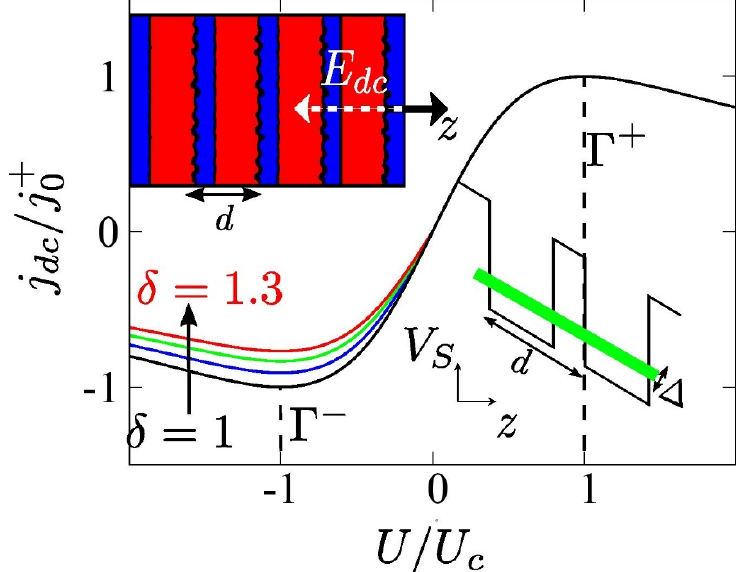
Figure 1. The current–voltage characteristics, j dc ( U ) , in the absence of an oscillating field for different values of the asymmetry parameter, from bottom (black) to top (red) as follows: δ = 1, 1.1, 1.2, 1.3. The left inset is a schematic representation of the semiconductor superlattice with a superlattice period, d, which results in the asymmetric current flow. The SSL is biased by a static electric field E = ( 0,0, E dc ) antiparallel to the growth axis ( − z ) of the superlattice structure. The right inset corresponds to the tilted superlattice potential V s due to the application of the electric field. The shaded green region indicates the first miniband with width Δ .